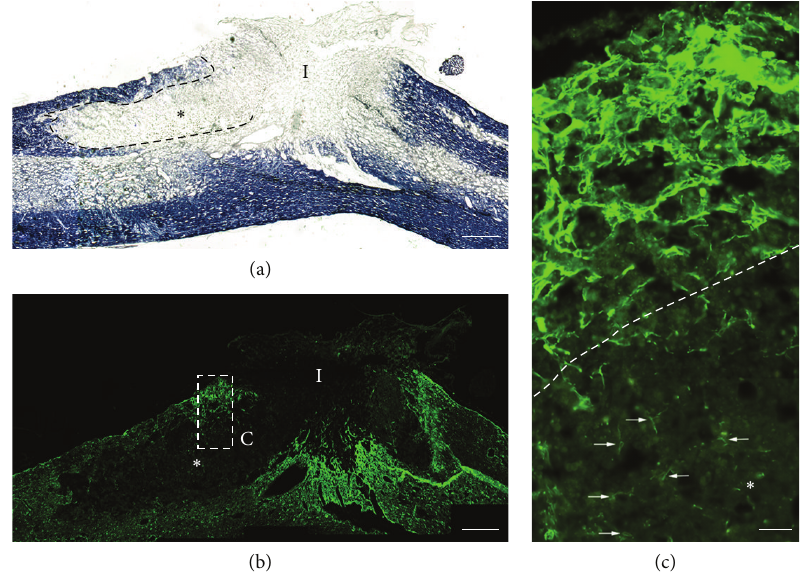
Figure 4: Immunological demyelination prevents astroglial hypertrophy following dorsal hemisection injury. (a) Eriochrome cyanine R- stained parasagittal section showing the extent of the demyelination ( ∗ ) in the dorsal column rostral to the hemisection injury site (I). (b) GFAP-stained parasagittal serial section to (a). Astroglial hypertrophy is evident surrounding the hemisection injury, but is absent within the region of immunological demyelination ( ∗ ). (c) Higher magnification of box in (b) showing the edge of the region of gliosis within normal white matter above the region of demyelination (hatched line indicates the border of the region of demyelination). The arrows demark a few of the many astrocytes present within the region of demyelination. Note that these astrocytes are small and have short and thin processes characteristic of quiescent astrocytes, which contrast with the hypertrophic astrocytes within the region of gliosis immediately above. Scale bars: (a) and (b) 400 𝜇 m; (c) 50 𝜇